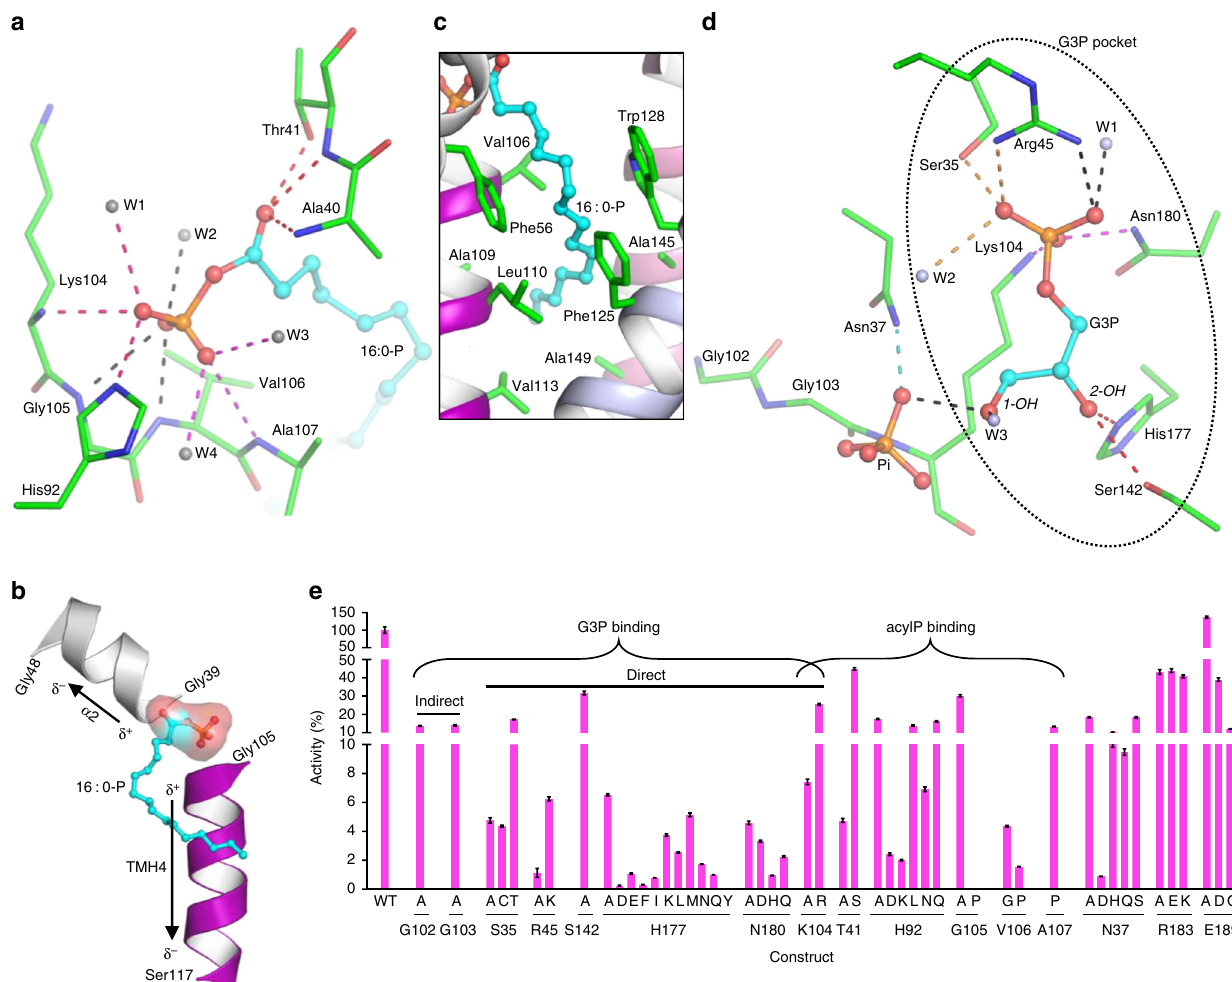
Fig. 4 Interactions between aa PlsY and its substrates 16 : 0-P and G3P, and structure-based mutagenesis. a Interactions between the acylP head group and the enzyme. b The involvement of two α -helices in acylP binding. The aggregate effect of individual backbone microdipoles aligned along the α -helices axis (black arrows) causes a dipole moment with its positive pole at the N terminus and its negative pole at the C terminus. The resultant partial positive charges ( δ + ) at the N termini of the α 2 ( n = 10) and the TMH4 ( n = 13) neutralize the phosphate charges of 16 : 0-P. c The hydrophobic groove that hosts the acyl chain of 16 : 0-P. Residues within 4.0 Å of the palmitoyl chain are shown as green sticks. d The G3P binding pocket. Dashed lines in a and d indicate distances within 3.2 Å. When appropriate, the dashed lines are colored differently for better visualization. e The activity of the wild-type and mutant enzymes. The wild-type activity (34.55 ± 3.14 μ mol min − 1 mg − 1 , mean ± SD) was obtained from six independent experiments, and the mean value was set to 100%. Puri fi ed mutants were assayed under eleven different G3P concentrations without technical replicates. G3P concentrations typically span three orders of magnitude with the high concentrations saturating the system. The V max and SE from the Michaelis – Menten fi tting are reported. Residues involved in binding of the two substrates are indicated